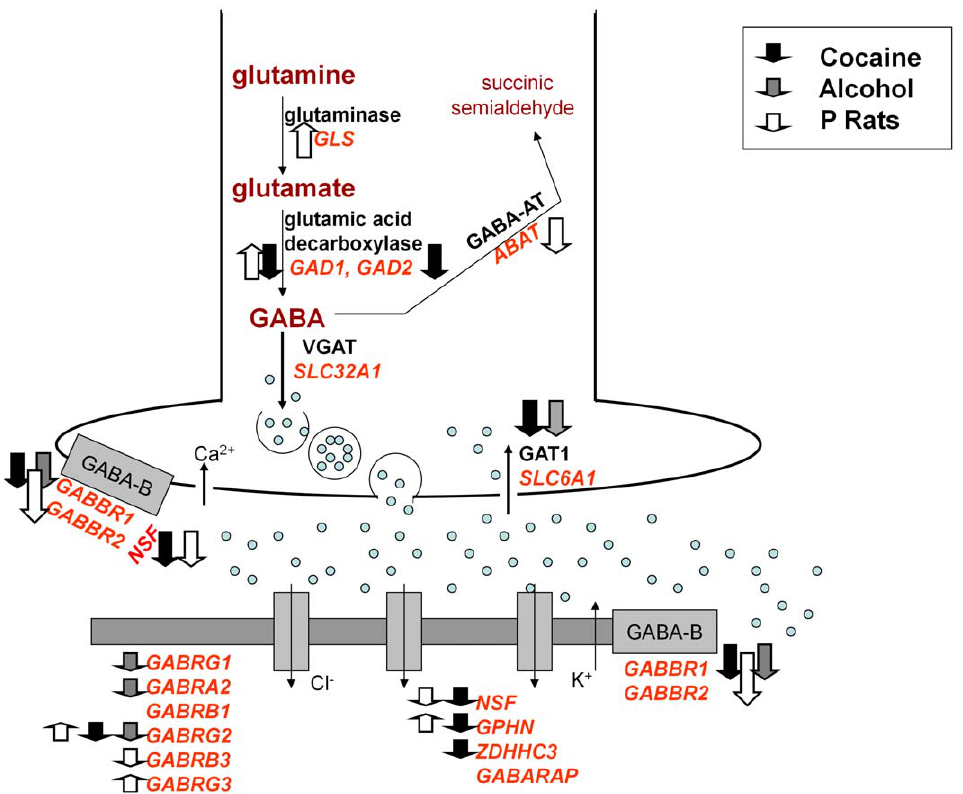
Figure 5. A Summary of Gene Expression Changes in Human Samples and in P Rats Relative to NP Rats. This schematic summarizes the gene expression changes shown in Table 2 (FDR p # 0.06).